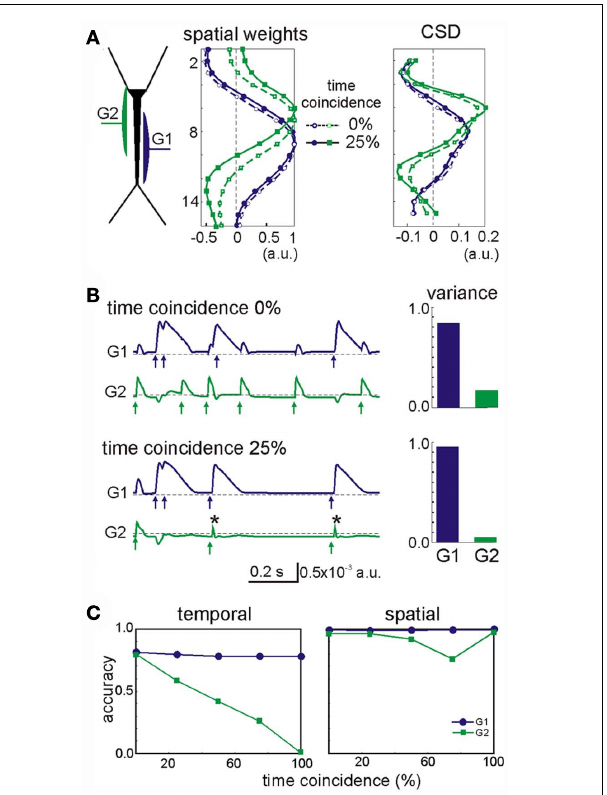
FIGURE 4 | Spatial and temporal cross-contamination between LFP-generators with a strongly unbalanced contribution. (A) The example corresponds to LFPs modeled by combining spatially overlapping of GABA B dendritic inhibition (G1, blue) and perisomatic GABA A inhibition (G2, green). Irregular series of synaptic inputs were injected in the two generators with a variable degree of temporal coincidence between them (case I: 0% and case II: 25%).The spatial distribution of the strong generator (G1) was stable, but that of the weak generator (G2) underwent a slight spatial shift when the two inputs had a partial temporal coincidence (25% of the time), which did not however modify the estimation of the synaptic loci (CSD). Note the small bump in the CSD curve of the weak generator at the site where the stronger generator peaked. (B) Cross-contamination can also be observed in the respective time courses of the generators (arrows mark the timings of synaptic inputs and asterisks show coincident inputs).The cross-contamination grew larger as the inputs coincided for a longer period (case I vs. case II). G1 got extra power (variance) from G2. (C) The strong generator (G1) practically does not suffer from coincident inputs. However, the time course of the weak generator (G2) may be severely distorted by coincident inputs and a significant part of its contribution lost.The spatial distribution of the weak generator also becomes worse for higher coincidence level, but at 100% coincidence G2 recovers its original spatial distribution (see main